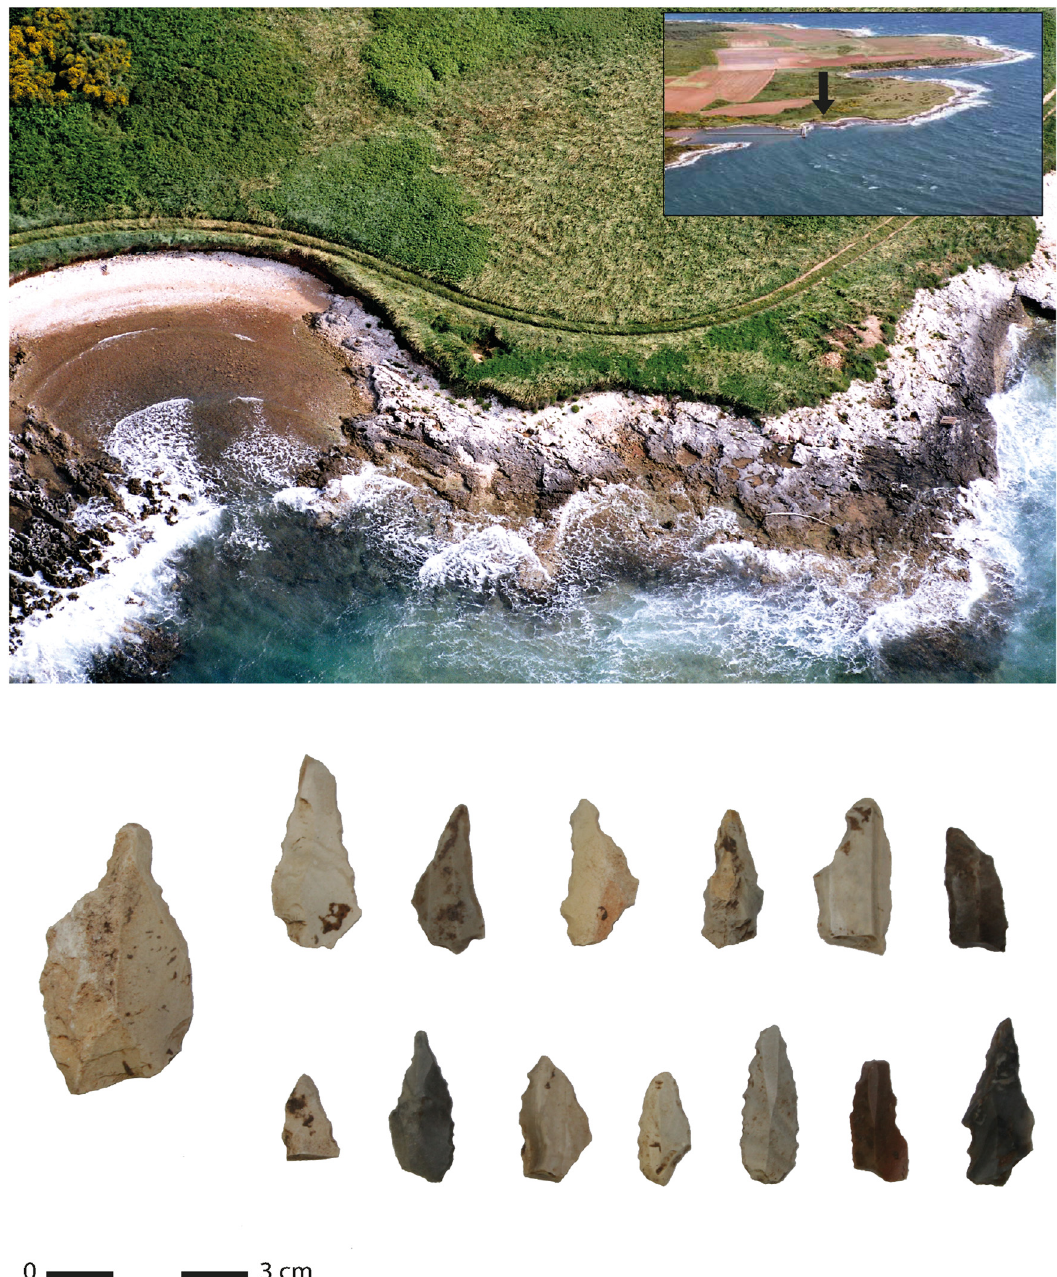
Figure 4: Kargadur ( Istria ) . Above: position of the site ( credits: D. Kom š o and Archaeological Museum of Istria ) . Below: bladelet - like fl akes and bladelets retouched by abrupt or semi - abrupt removals representing perforators and